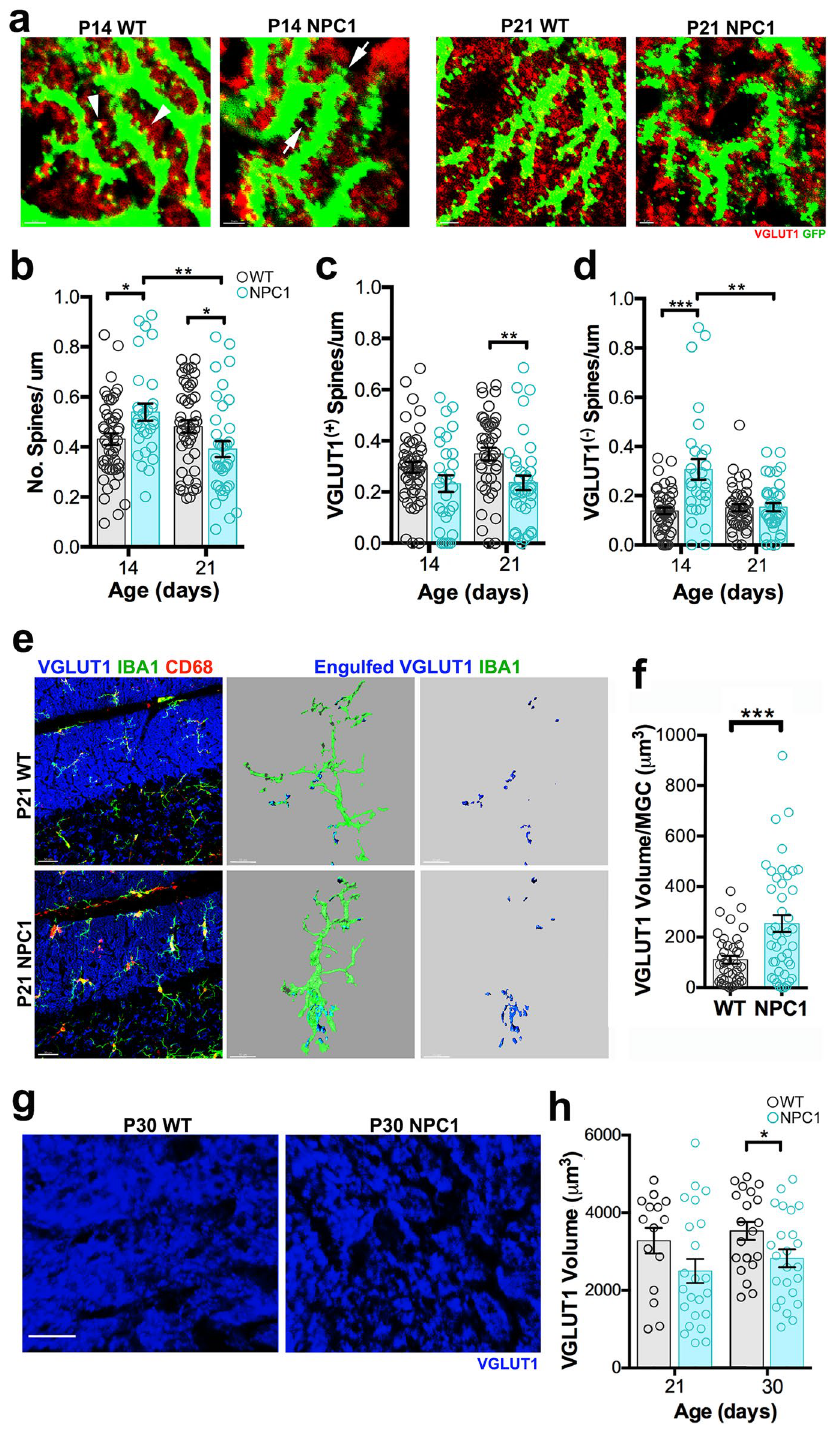
Figure 3. ( a ) Interactions between GFP + PC dendritic spines and VGLUT1 + presynaptic terminals in WT and Npc1 nmf164 mice at P14 and P21. Arrowheads showing VGLUT1 (+) GFP + spines, arrows showing VGLUT1 (−) GFP + spines. ( b ) Quantitative analysis of the total number of spines per μm. ( c ) Quantitative analysis of the number of spines that are contacted by VGLUT1 + presynaptic terminals. ( d ) Quantitative analysis of the number of spines that are not contacted (VGLUT1 (−) ) by VGLUT1 + presynaptic terminals. Data are presented as mean ± SEM, n = 3–4 mice/genotype/age, n = 10 dendritic segments/ mouse. ( e ) Confocal images and 3D surface renderings showing segregated IBA1 + microglial cells from P21 WT and Npc1 nmf164 mice contacting or engulfing VGLUT1 + presynaptic inputs. The third column is showing 3D surface renderings of the contacted or engulfed VGLUT1 + presynaptic inputs. ( f ) Quantitative analysis of the total volume of contacted or engulfed VGLUT1 + presynaptic inputs in P21 IBA1 + microglia. ( g ) Quantitative analysis of the total volume of VGLUT1 + presynaptic inputs in the ML of P30 mice. Data are presented as mean ± SEM, WT n = 44 cells from 4 mice, Npc1 nmf164 n = 46 cells from 4 mice. *P < 0.05, **P < 0.01, ***P < 0.001, ****P < 0.0001. Scale bar: ( a ) 3 μm, ( e ) 30 μm, ( g ) 10